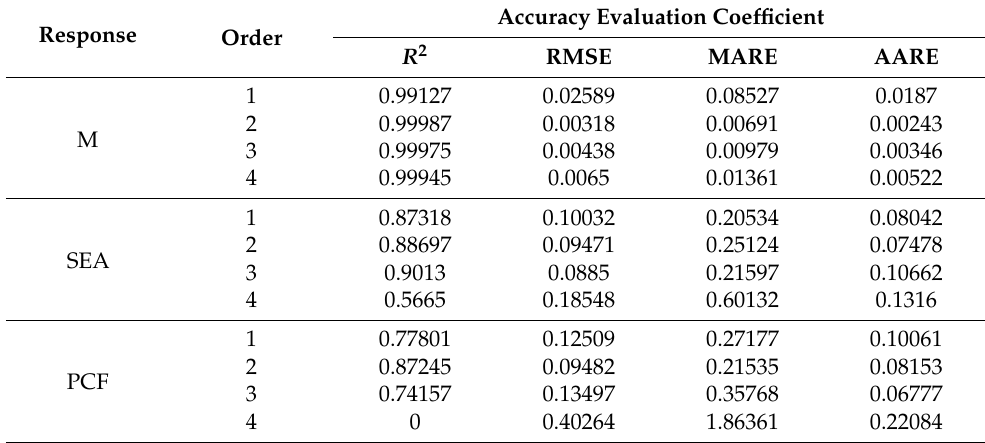
Table 8. Accuracy assessment of the surrogate model of response surface models 1–4.